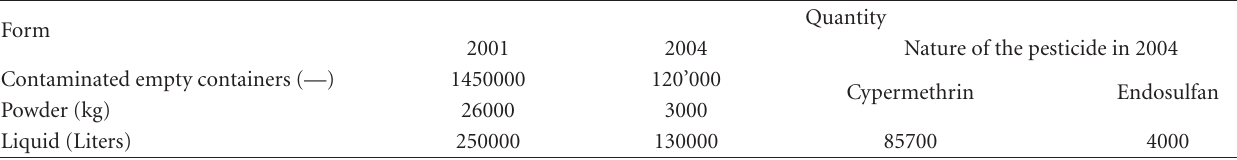
Table 1: Results of the surveys of POPs and obsolete pesticides in Burkina Faso (2001 and 2004) [3]. Quantity Form 2001 2004 Nature of the pesticide in 2004 Contaminated empty containers (—) 1450000 120’000 Cypermethrin Endosulfan Powder (kg) 26000 3000 Liquid (Liters) 250000 130000 85700